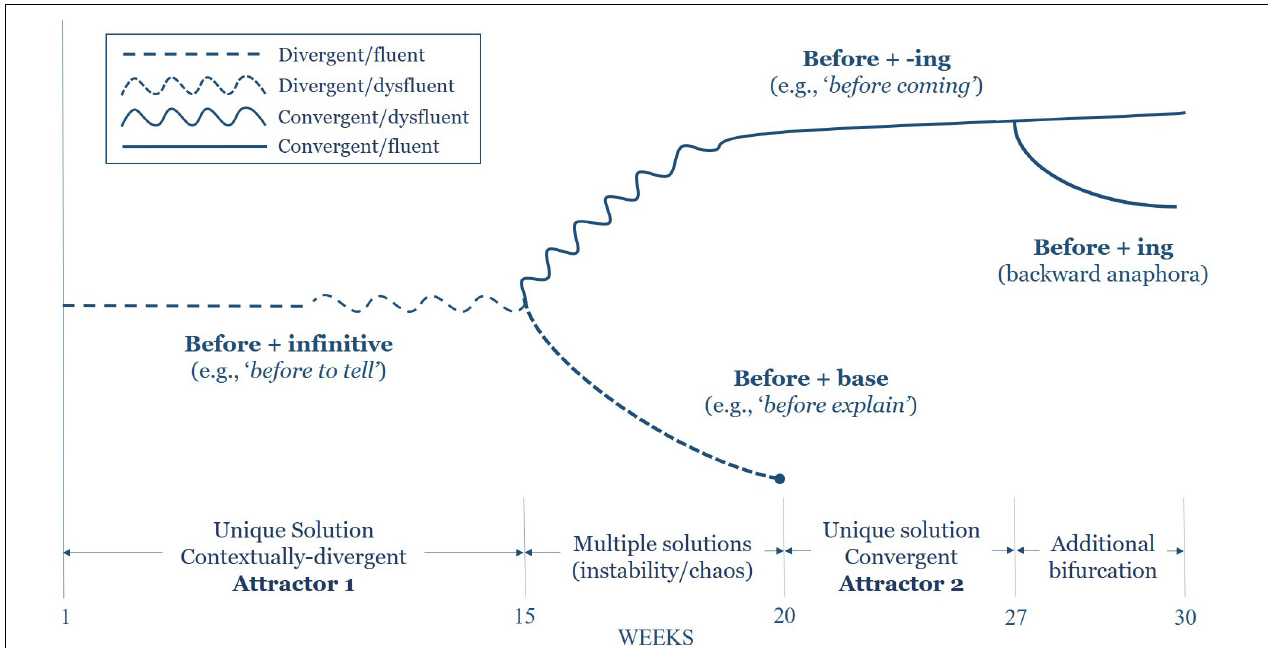
FIGURE 1 | Bifurcation region of before-headed non-finite adverbial